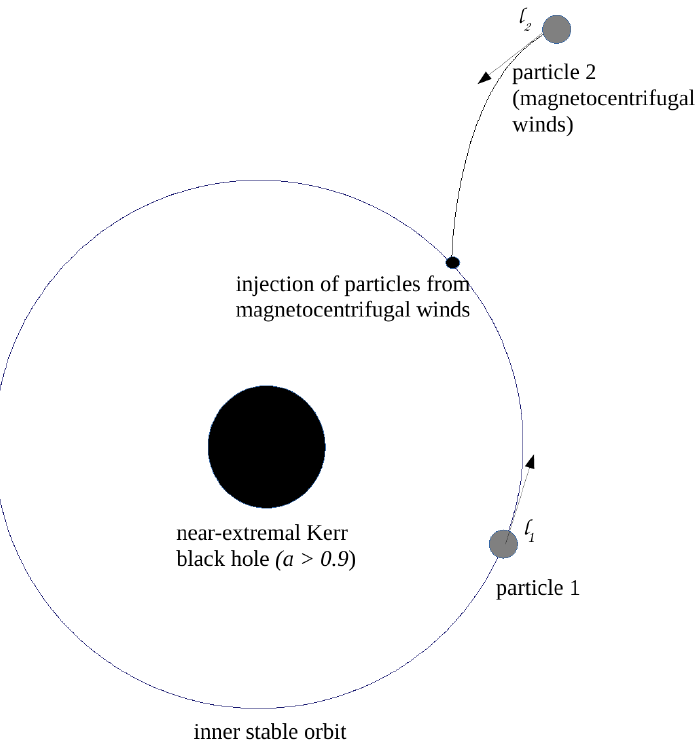
Figure 6. Sketch of the mechanism: particles from the magnetocentrifugal wind could reach the inner stable orbits triggering high-energy